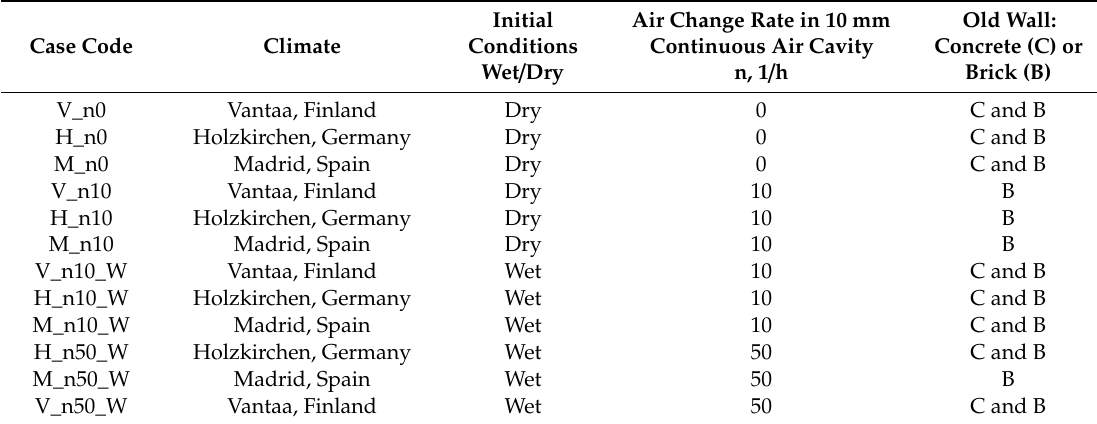
Table 7. Numerically analyzed cases for ventilation scheme 1.